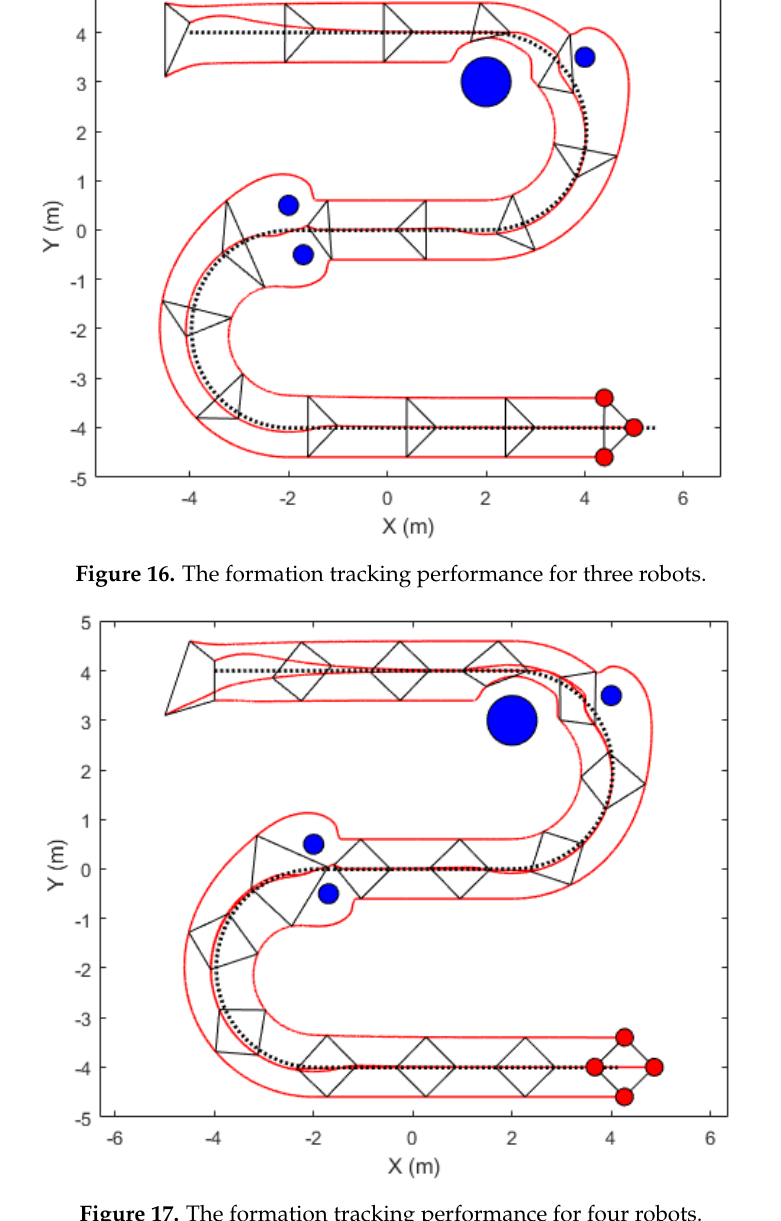
Figure 17. The formation tracking performance for four